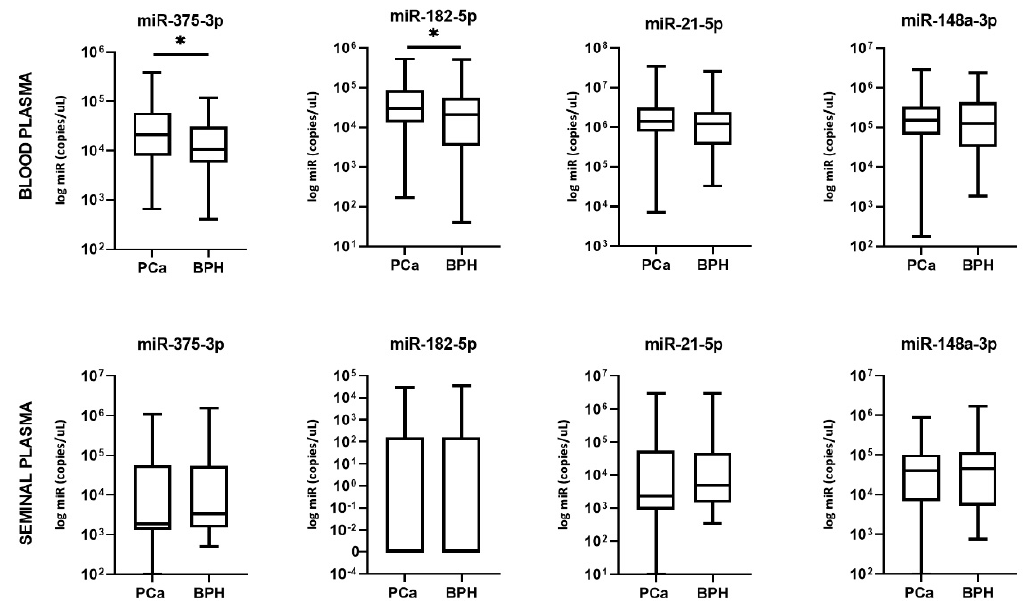
Figure 1. Blood and seminal plasma miRNA levels in PCa patients compared to BPH patients. Significant differences between groups are indicated: * p < 0.05.